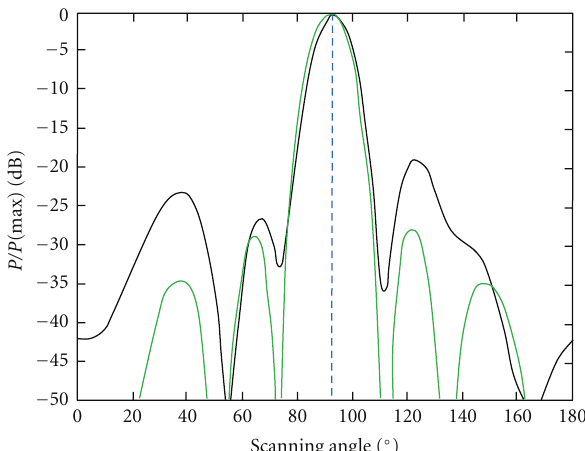
Figure 3: The beam pattern received with 10 neurons in the hidden layer—following ES.